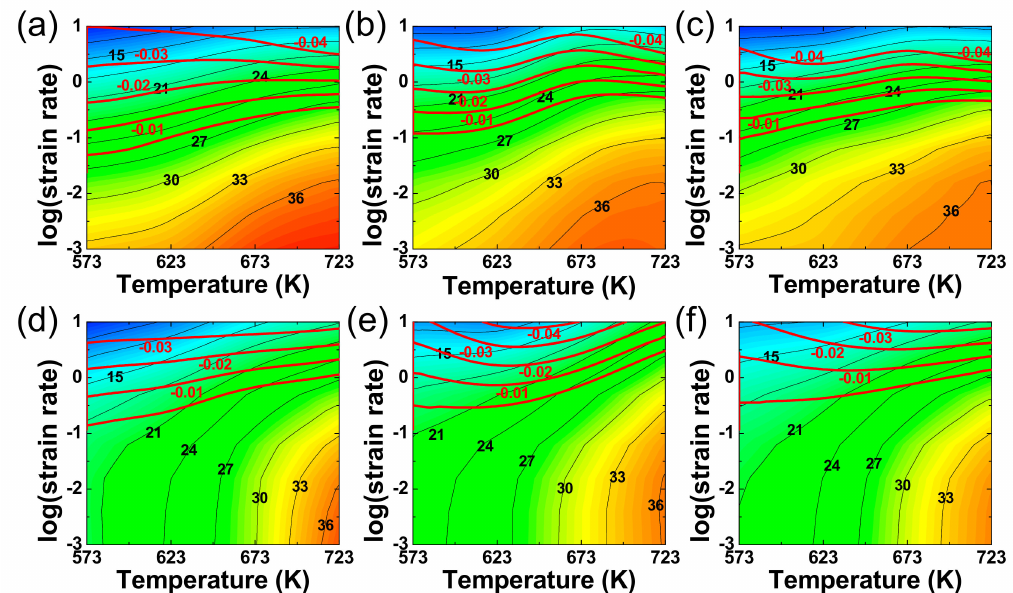
Figure 5. The processing maps of the as-cast alloy at ε values of ( a ) 0.2, ( b ) 0.6 and ( c ) 1.0. The processing maps of the extruded alloy at ε values of ( d ) 0.2, ( e ) 0.6 and ( f ) 1.0. The black color contours and numbers represent the η values, while the reddish color contours and numbers represent the ξ values in the regime of flow instability.